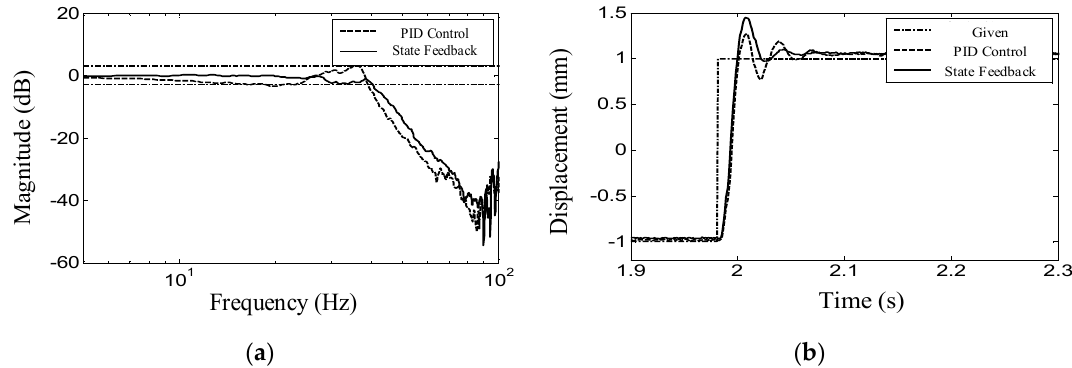
Figure 11. Three-state feedback effect diagram: ( a ) frequency characteristics and ( b ) step response.